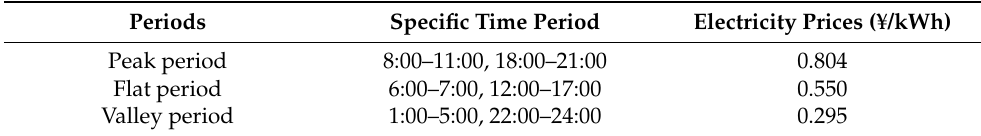
Table 2. TOU ELECTRICITY PRICES.